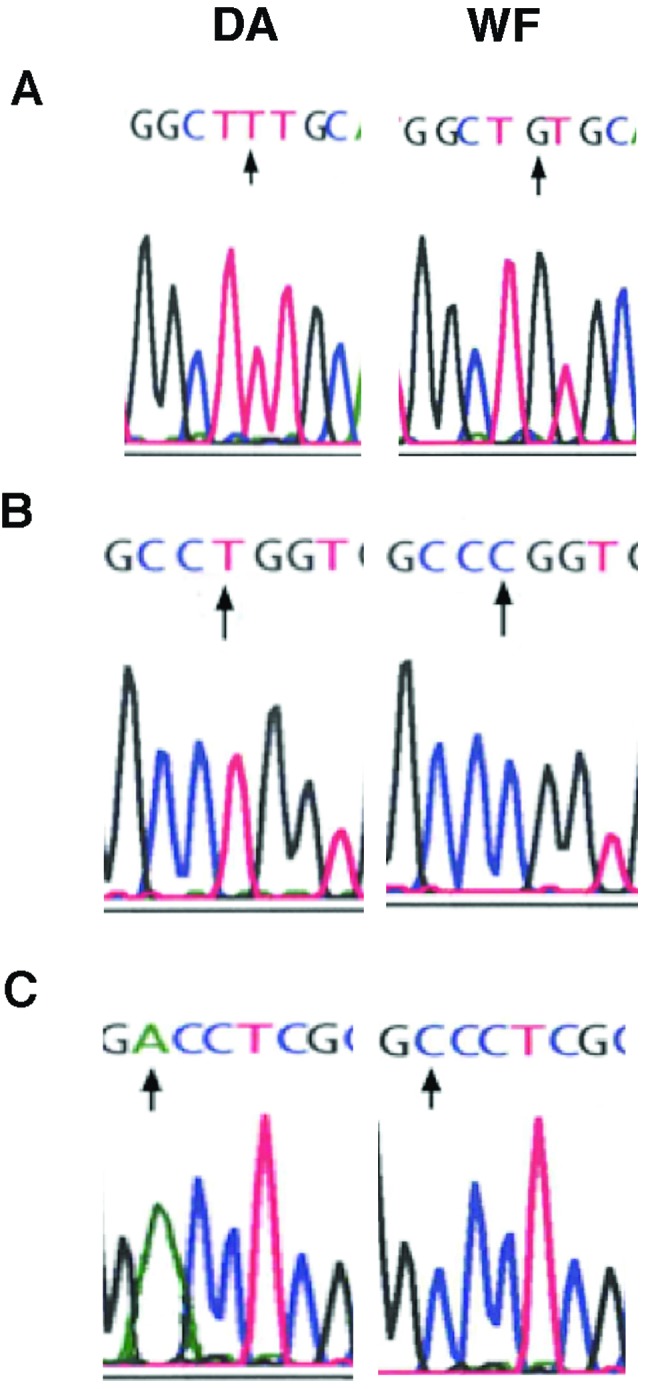
Detection of sequence variants in the Pthlh gene in the WF and DA strains. The WF strain contained 3 SNPs not noted in the DA and 6 other inbred strains of rat. The SNPs were located at positions (A) +2 bp, (B) +17 bp and (C) +513 bp. The sequences of the primers used for PCR amplification before sequencing were: Pthlh 1 F, 5′-GACTCGCTCACT TCTCAGCA-3′ and R, 5′-GGCTCCCATAGCAATGTCTA-3′; Pthlh 2 F, 5′-GCGGTGTCTGAGCACCAGCTA-3′ and R, 5′-GCACAGCGGACAGAC AATACC-3′. Primer pair 1 was used to amplify the SNPs at positions +2 and +17 bp; pair 2 amplified the SNP at position +1485 bp (B). WF, Wistar-Furth rats; DA, Dark Agouti rats.